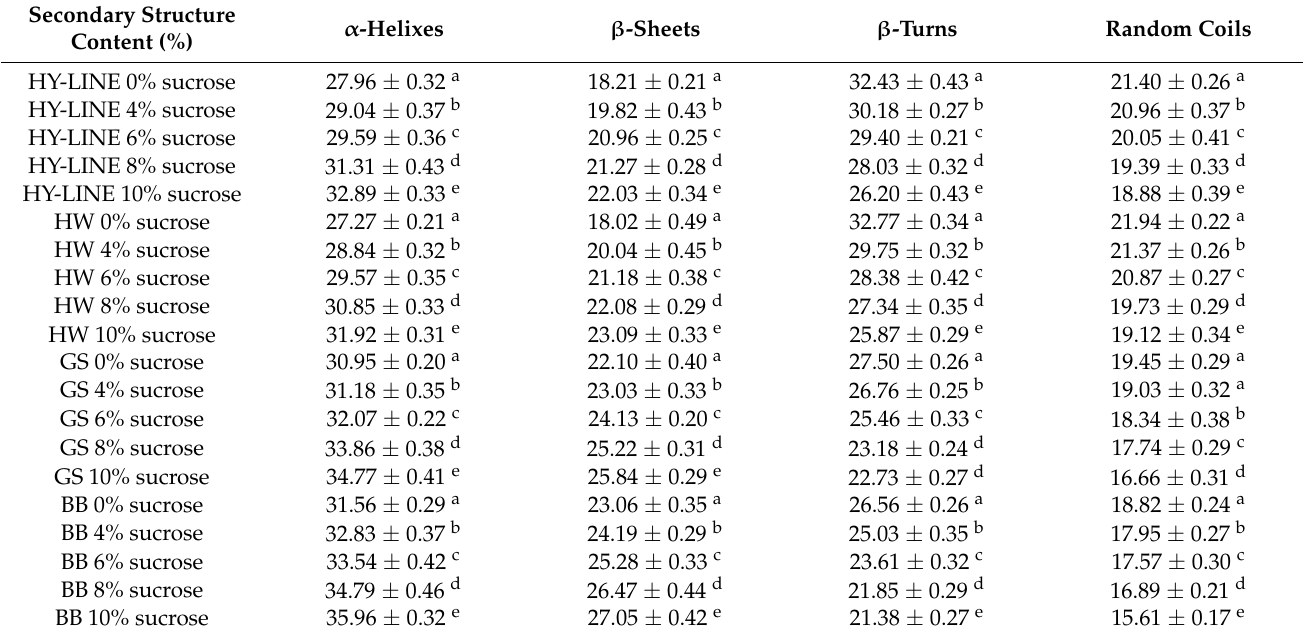
Table 4. Content of α -helixes, β -sheets, β -turns and random coils in four varieties after addition of sucrose and subjection to heat